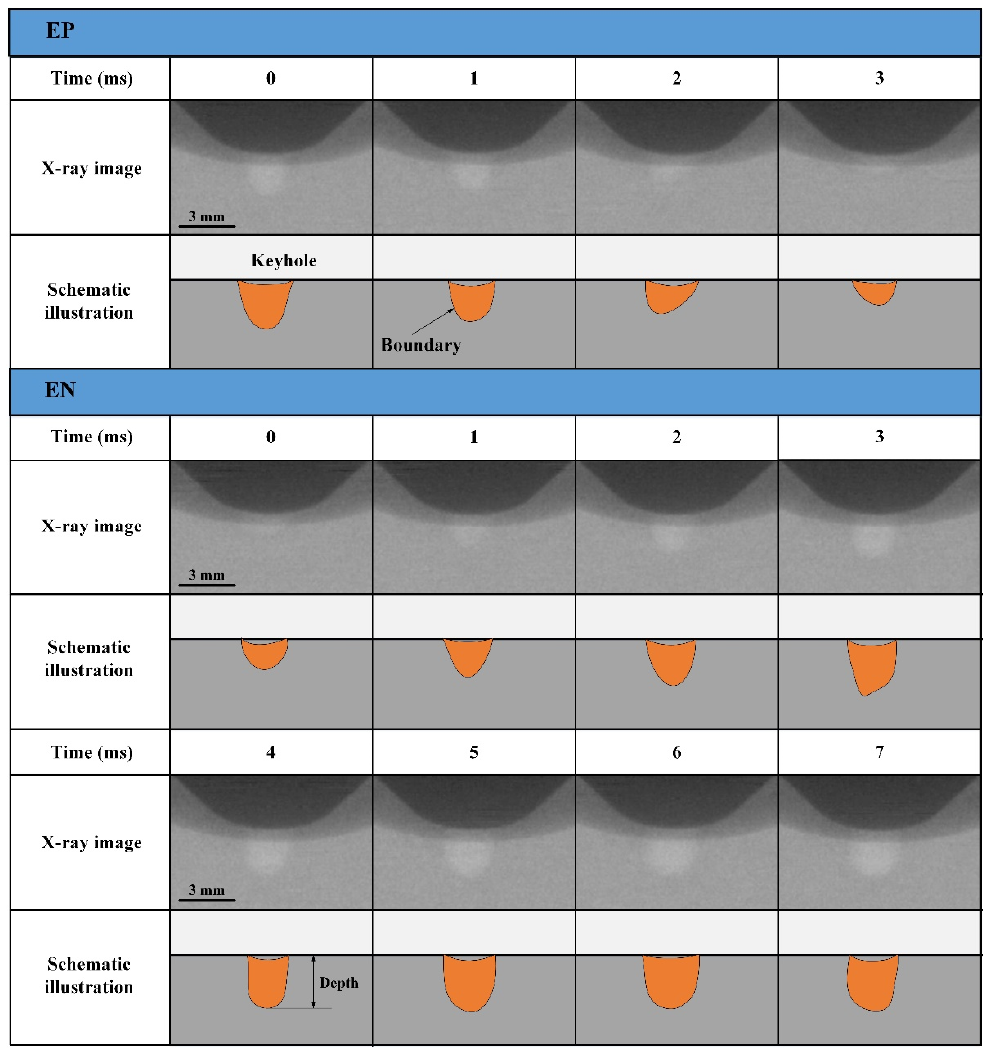
Figure 8. Dynamic characteristics of keyhole during the digging process shown by X-ray imaging Figure technology.